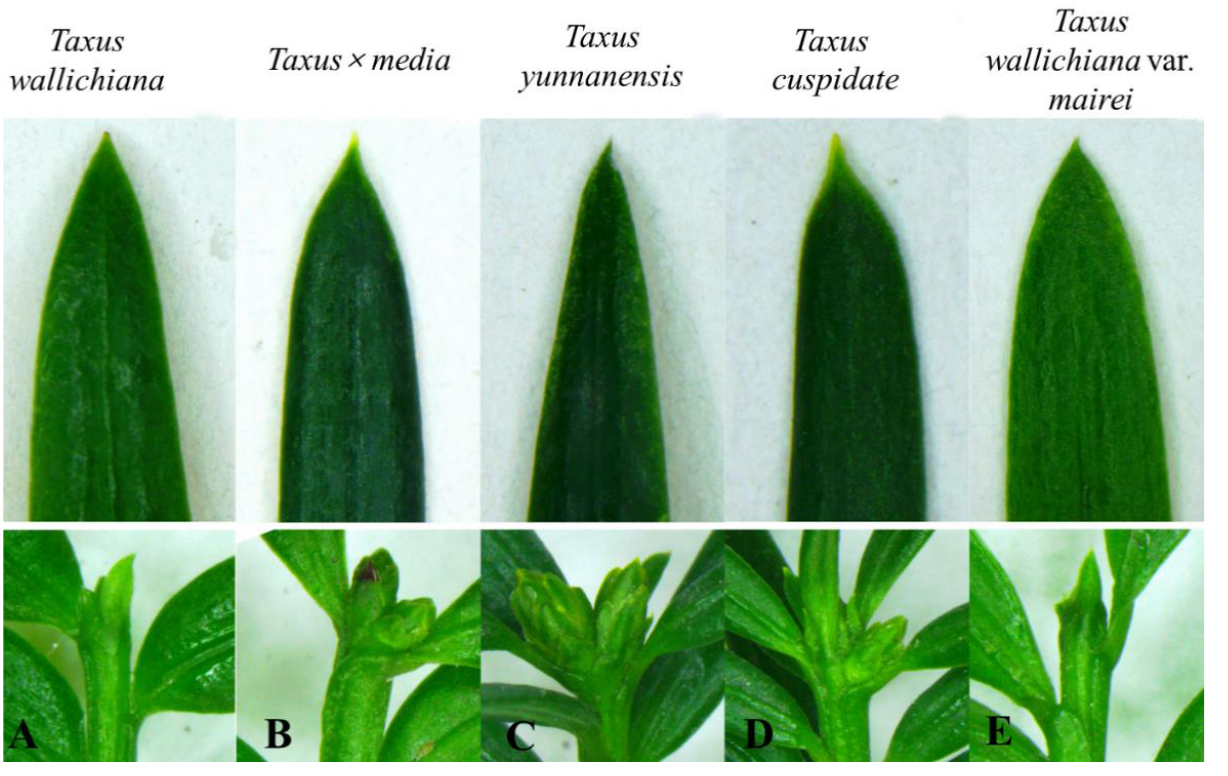
Figure 1. Morphological comparison of the leaves and bud. ( A ) T. wallichiana, ( B ) T. × media, ( C ) T. yunnanensis , ( D ) T. cuspidate, and ( E ) T. wallichiana var. mairei .